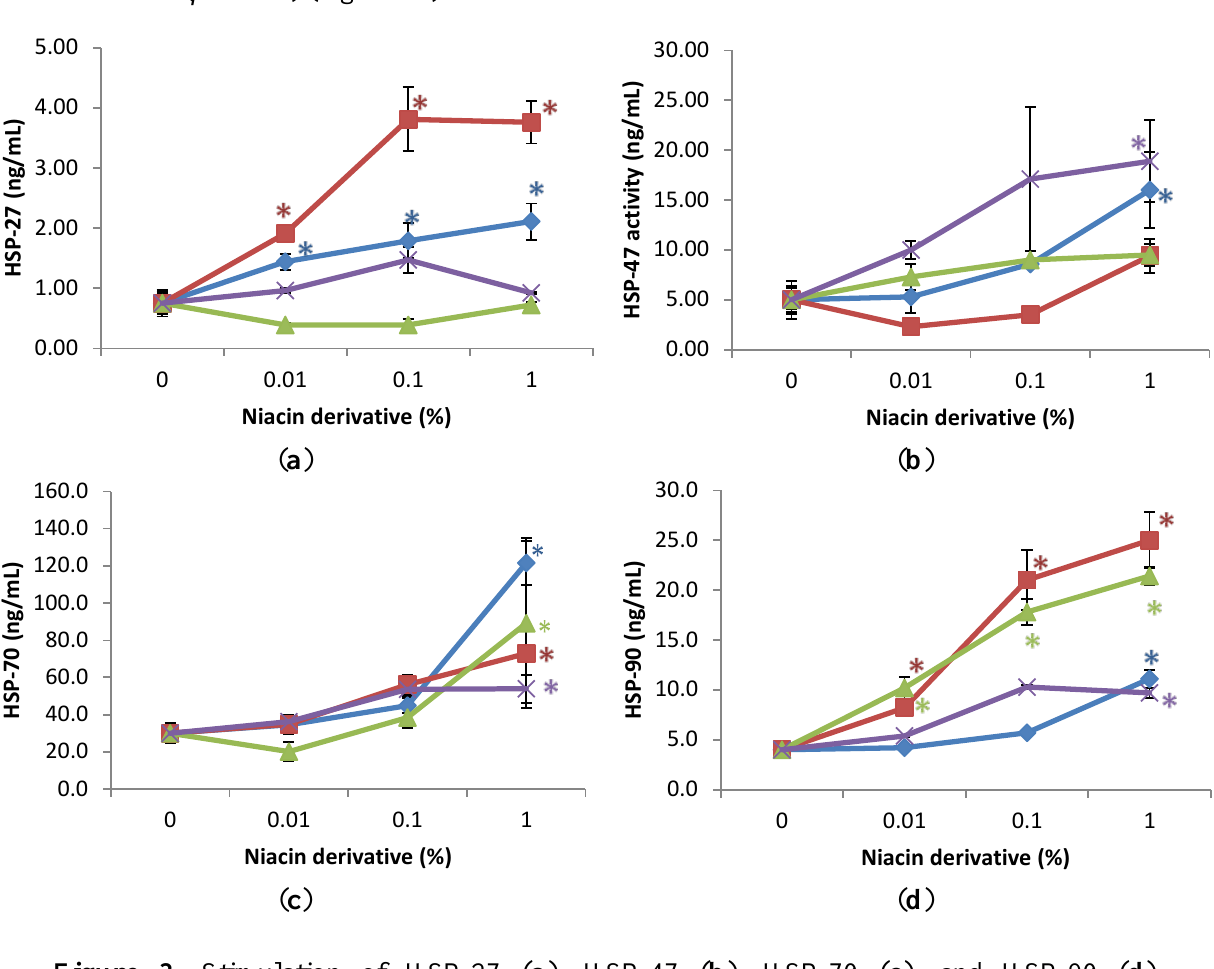
Figure 3. Stimulation of HSP-27 ( a ); HSP-47 ( b ); HSP-70 ( c ); and HSP-90 ( d ) proteins by nicotinamide (green line), 2,6-dihydroxynicotinamide (red line), 2,4,5,6-tetrahydroxynicotinamide (violet line), and 3-hydroxypicolinamide (blue line) in dermal fibroblasts; * p < 0.05, relative to control, error bars (a–d) represent standard deviation, n =